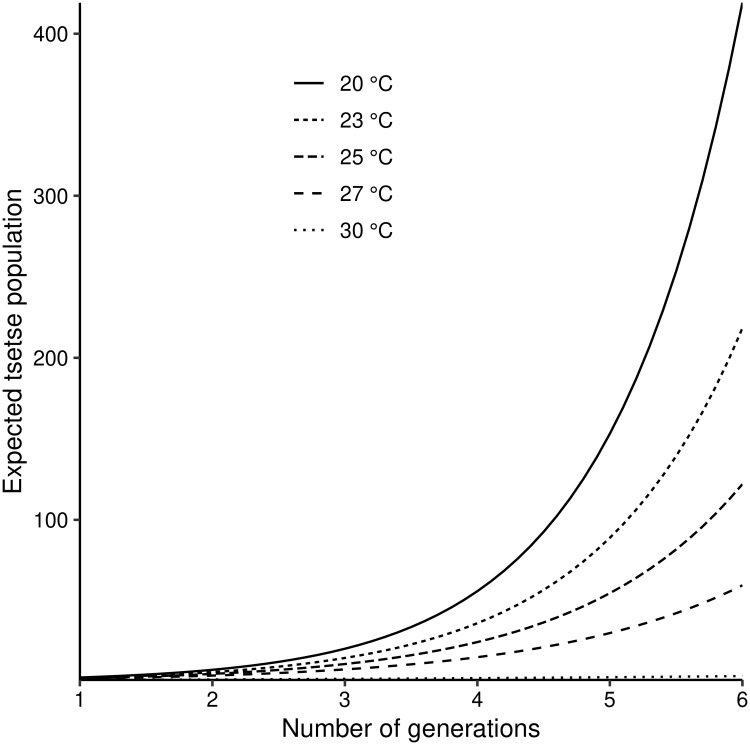
Expected growth in the numbers of adult females in a G. m. morsitans population at different temperatures (15°C–35°C).The projections are approximately valid for the early stages of growth, before density dependent processes have noticeable effects.